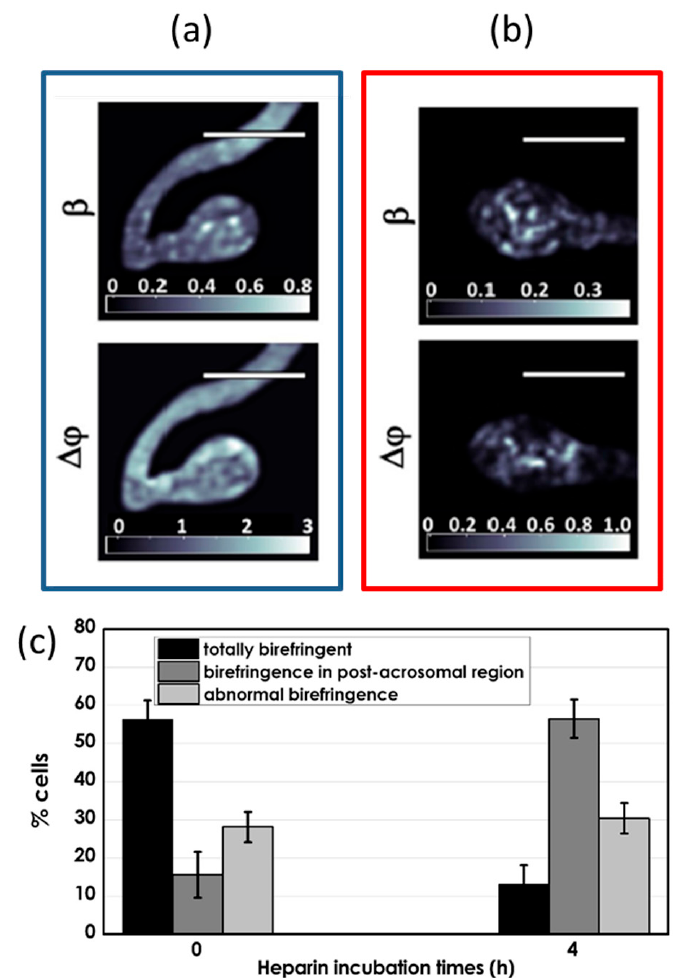
Figure 8. ( a ) Amplitude parameter β and phase difference Δ φ relative to a control sperm cell (0 h in heparin). Colorbars indicate the mapping of the phase variation. ( b ) The same polarization parameters measured for a reacted sample (4 h in heparin). ( c ) Distribution of birefringence patterns of sperm from three donors exposed to heparin for 0 h (control sample) and 4 h (reacted sample). Scale bar: 4 μ m (adapted from De Angelis at al. [30]).